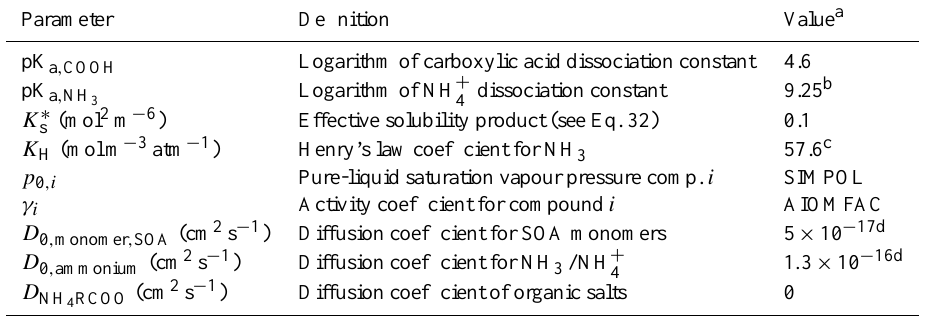
Table 3. Base case model set-up values for the simulation of organic salt formation between carboxylic acids and dissolved ammonium ions. Parameter Definition Value a pK a , COOH Logarithm of carboxylic acid dissociation constant 4.6